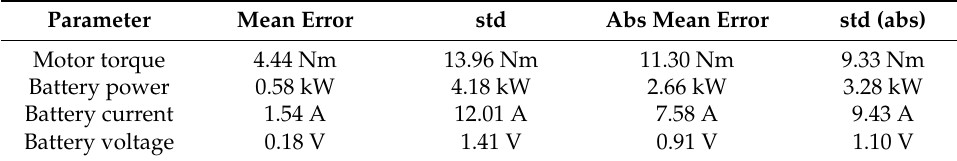
Figure 11. Battery SOC vs. lap time expressed in seconds. In particular, in the figure, there are the battery SOC (in percentage) resulting from the calibrated model (in red) and the battery SOC (in percentage) acquired through the VCU (in particular from the BMS) of the waste collection vehicle prototype (in blue). Table 3. Performance indices of the waste collection vehicle simulation.